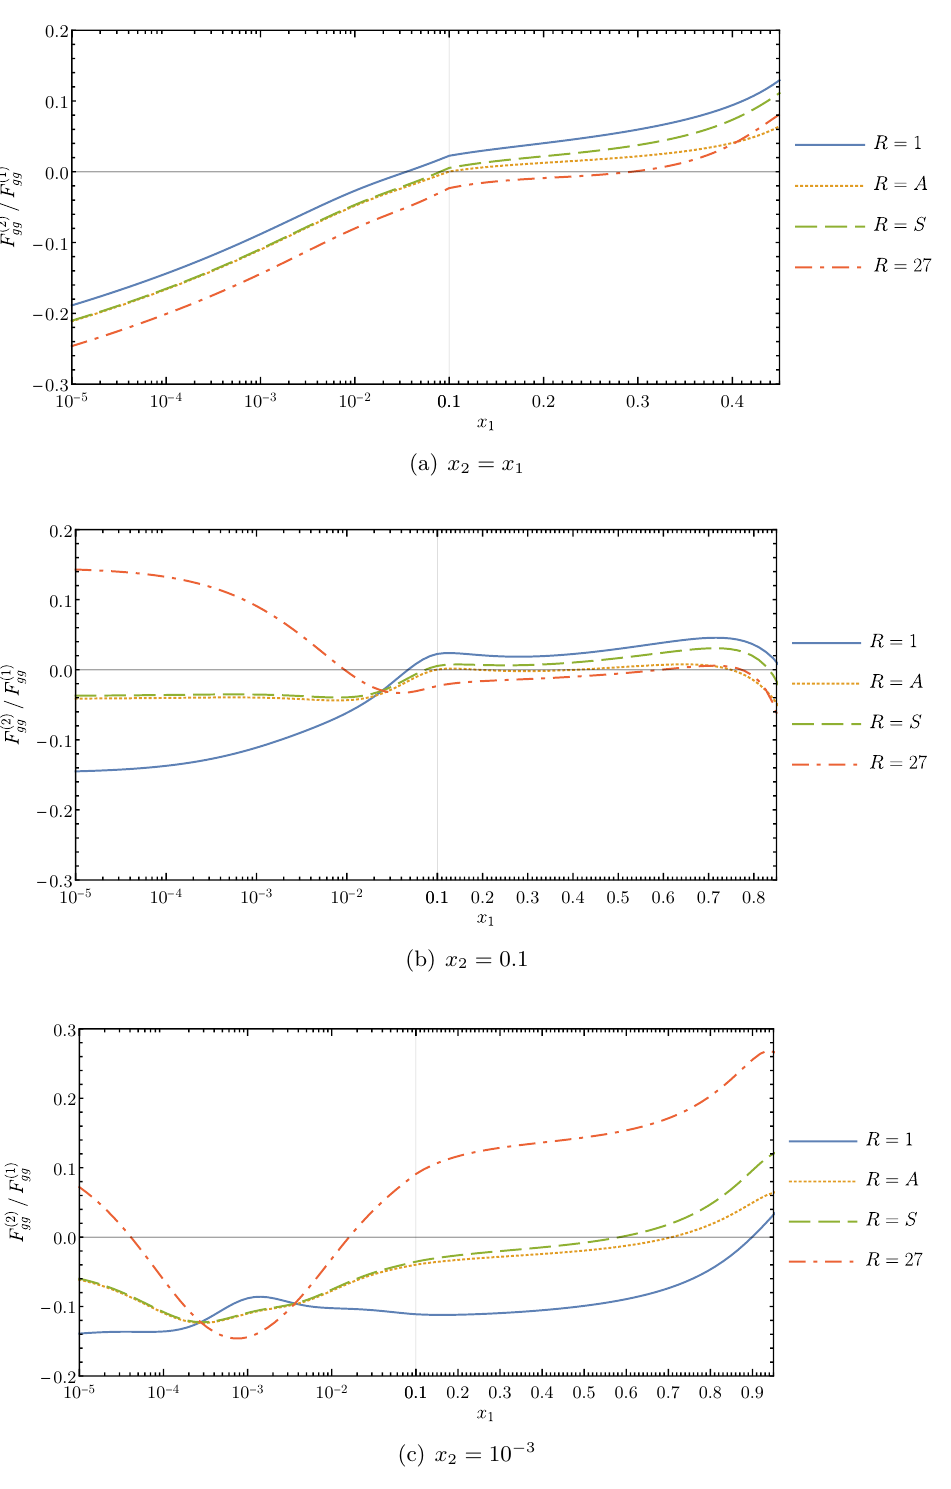
(cid:14) RR Figure 9 . The ratio RR F (2) gg F (1) gg , evaluated at central values of the scales as in figure